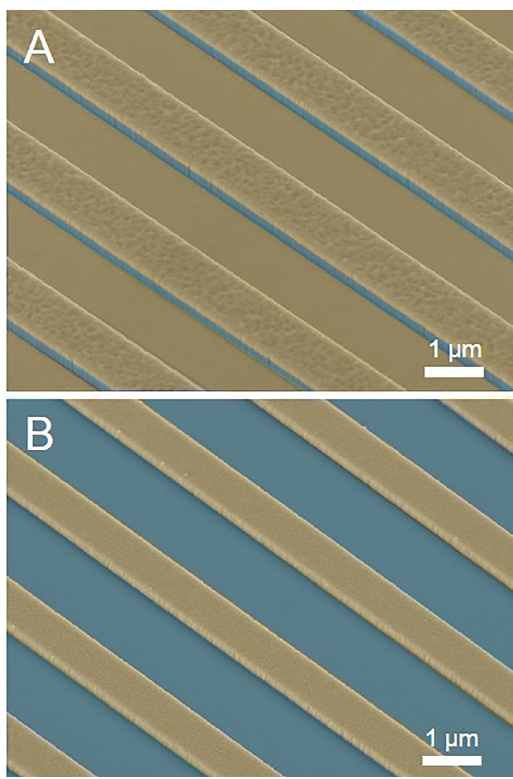
Figure 2: Colorized scanning electron microscope (SEM) images of A) etched and B) unetched detectors. Blue indicates the semiconductor region, gold indicates metallic regions. Images taken at 45 ° tilt angle. predicted 6.7 µm; metasurface QWIPs have slightly red- shifted peaks compared with the original QWIP. Unex- pected features can also be found in the peak height. The